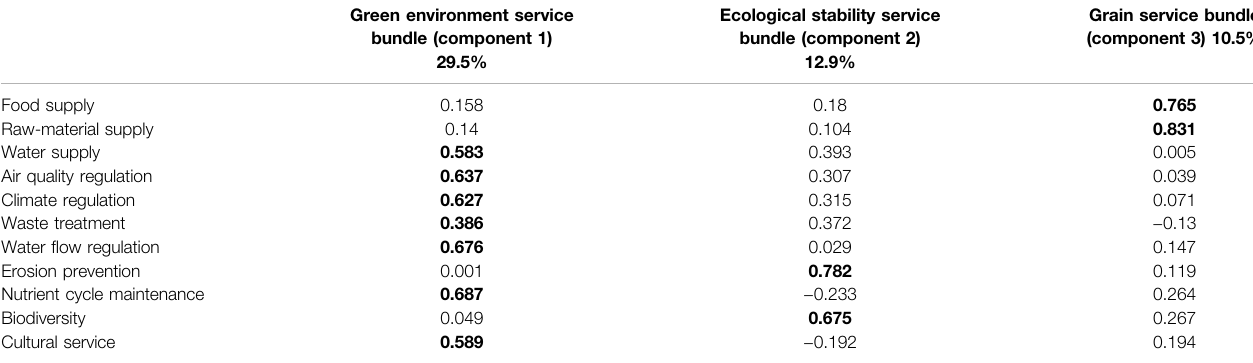
TABLE 2 | Principal component analysis (PCA) of ES perceived importance.